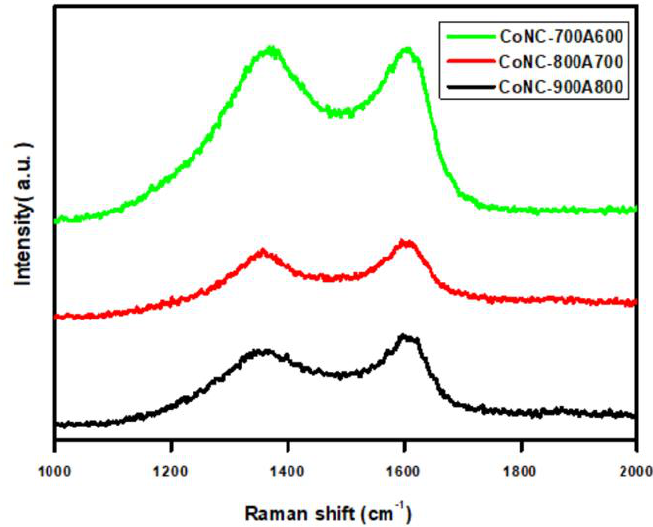
Figure 6. Raman spectra of (black) CoNC − 900A800 (red) CoNC − 800A700 (green) CoNC − 700A600. Table 1. Comparison of I D /I G of various cathode catalysts. CoNC- I D /I G a